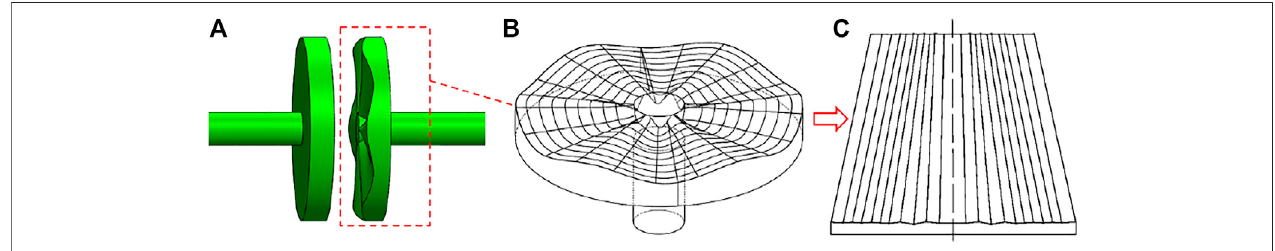
FIGURE 3 | Characteristics of the corrugated disc. (A) Flat-Corrugated transmission pair; (B) Wireframe of a corrugated disc; (C) Unfolding surface.